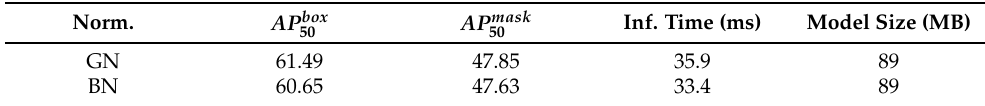
Table 5. Comparison of group normalization (GN) and batch normalization (BN). Norm. represents the normalization method.